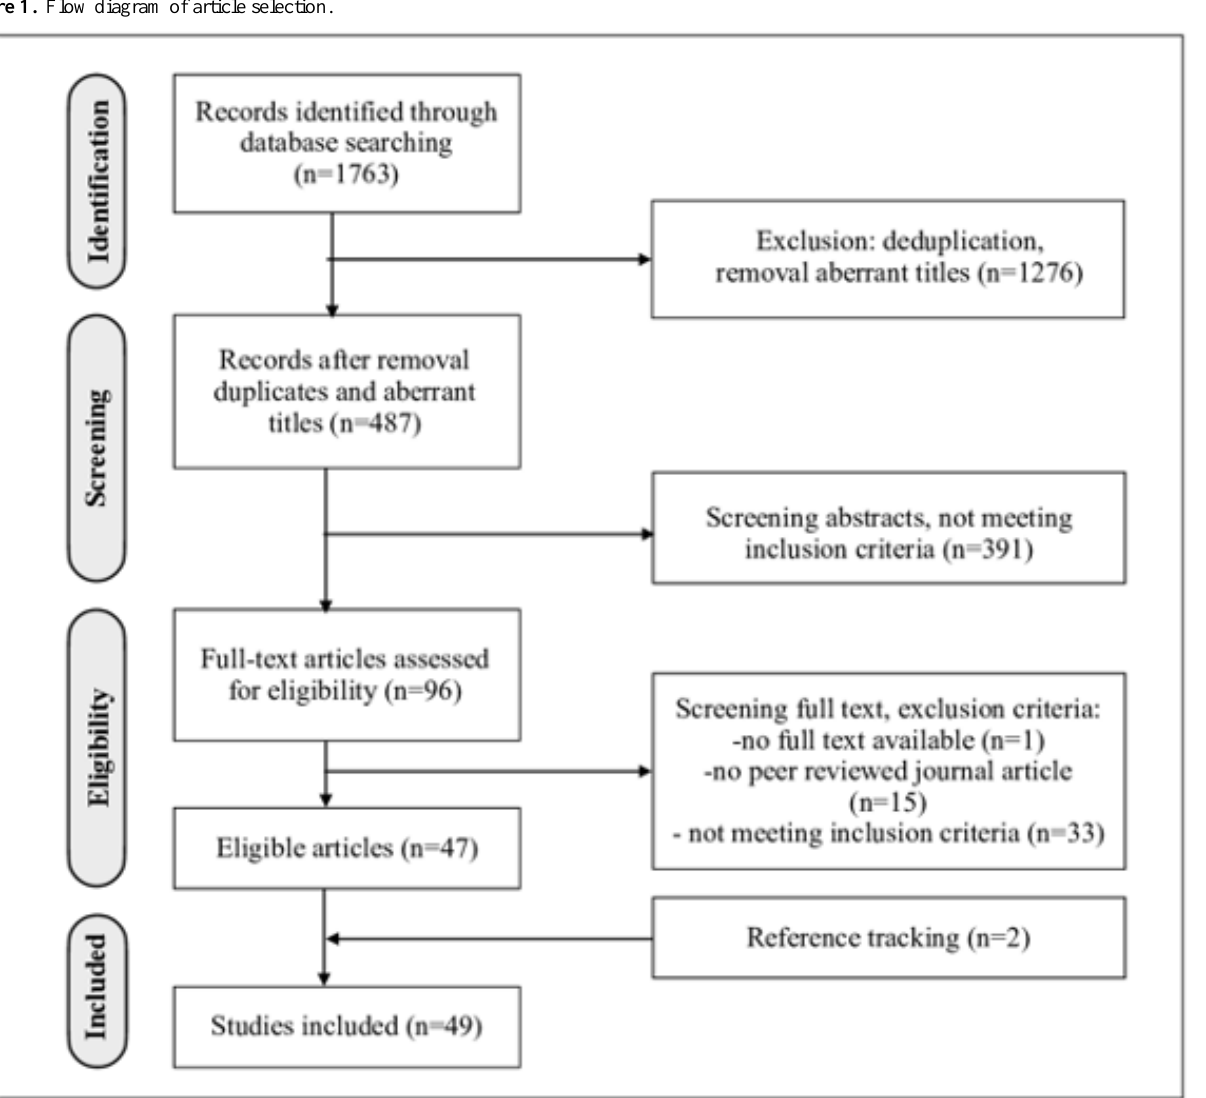
Figure 1. Flow diagram of article